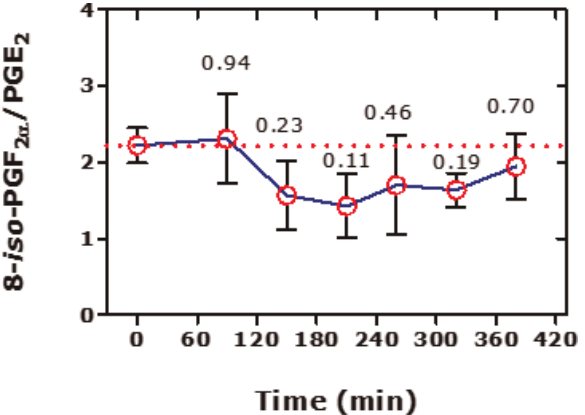
Figure 1. Effects of N -acetylcysteine (NAC) on the urinary 15( S )-8- iso -PGF 2 α /PGE 2 molar ratio in eight healthy subjects (4 females, 4 males) upon a single oral intake of 600 mg NAC. NAC was administered immediately after collection of the fi rst urine samples at time 0 h. Urinary excretion rates ranged between 25 and 183 nmol/mol creatinine for 15( S )-8- iso -PGF 2 α and between 65 and 315 nmol/mol creatinine for PGE 2 . Data are shown as mean ± SEM. The numbers indicate the Mann